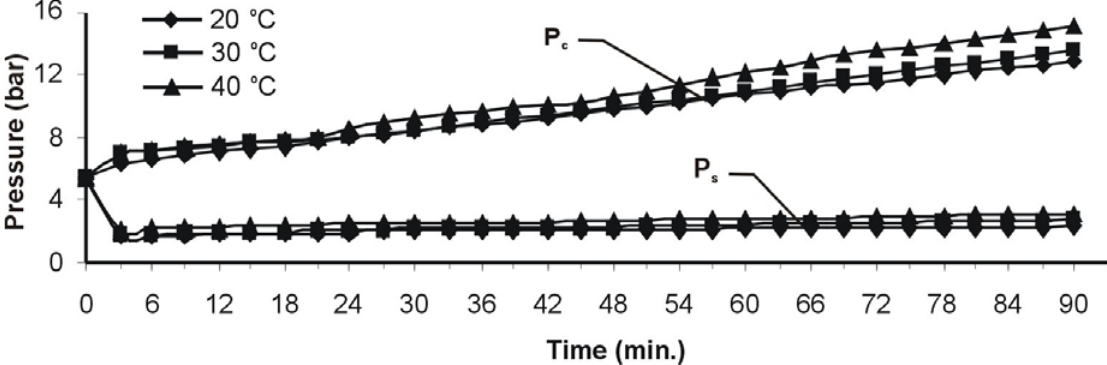
Figure 7. Pressure changes at the inlet and outlet of the compressor along the experiment for the circulation pump flow rate CP I .